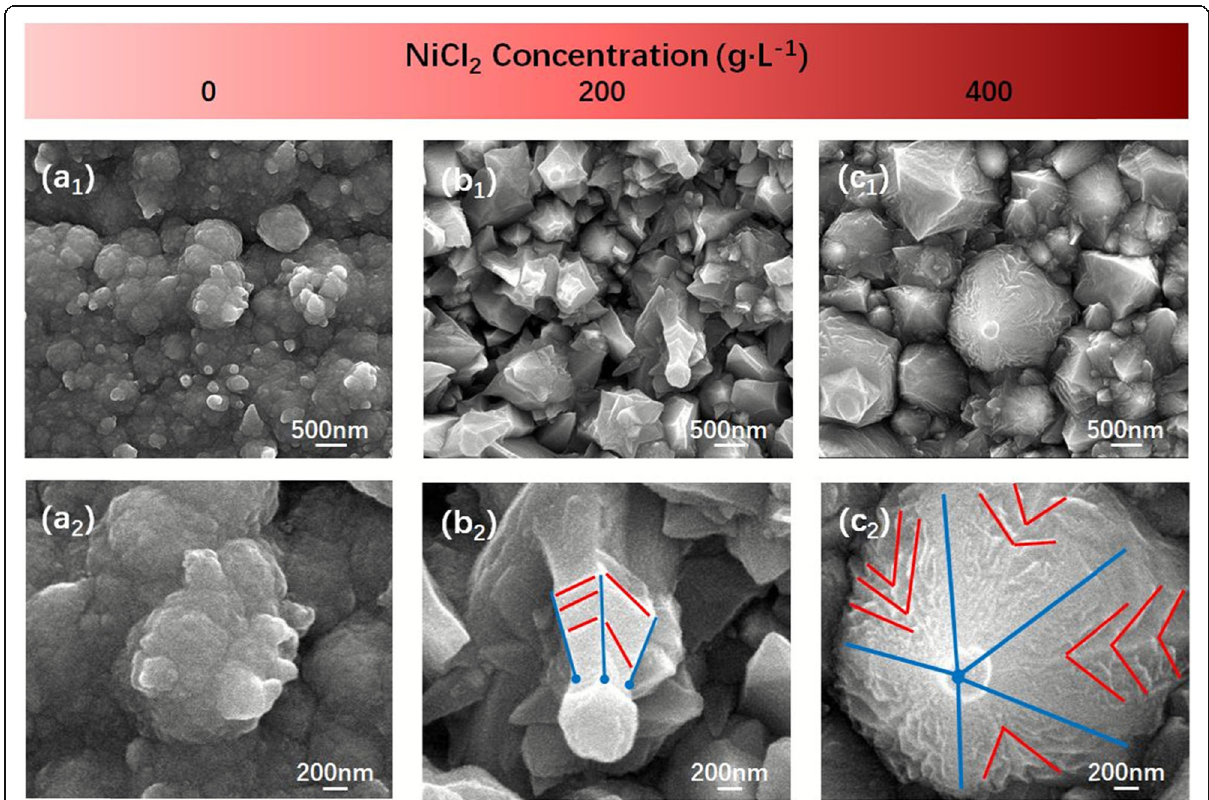
Fig. 5 Low- and high-magnification SEM images of cathode that electrodeposited at different NiCl 2 concentrations: 0 g/L ( a 1 , a 2 ), 200 g/L ( b 1 , b 2 ), and 400 g/L ( c 1 , c 2 ),